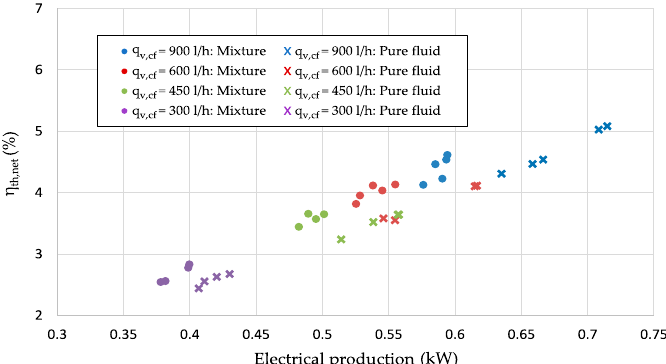
Figure 7. The ORC performance according to electrical production in the pure fluid and the mixture 364 (isoparameters). 365